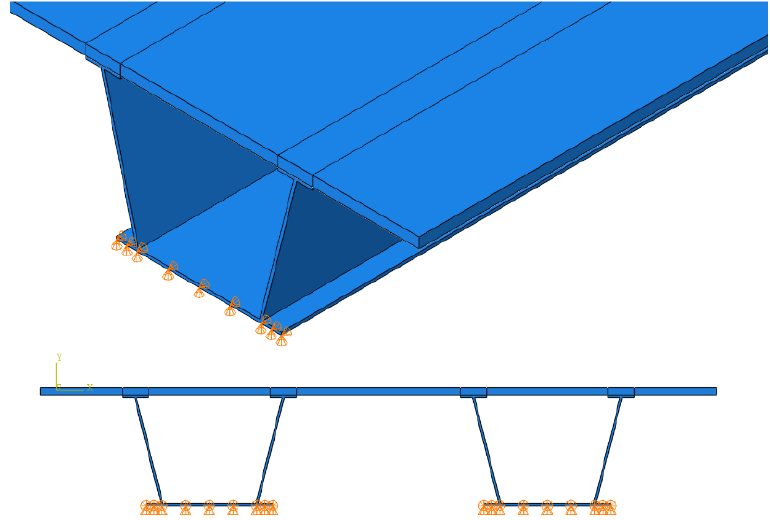
Figure 5. Boundary conditions of the models.